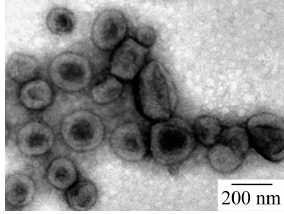
Figure 4. Transmission electron microscopy (TEM) image of the PICsome composed of P 20 M 190 and P 20 A 196 with f + = 0.5.